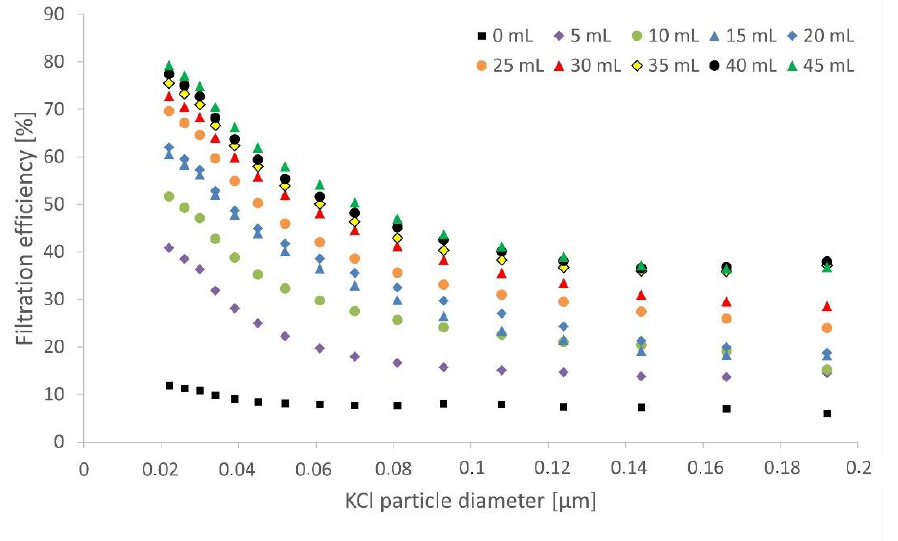
Figure 10. Dependence of the fractional filtration efficiency on the volume of 6% PLA solution used for the production of fibers.